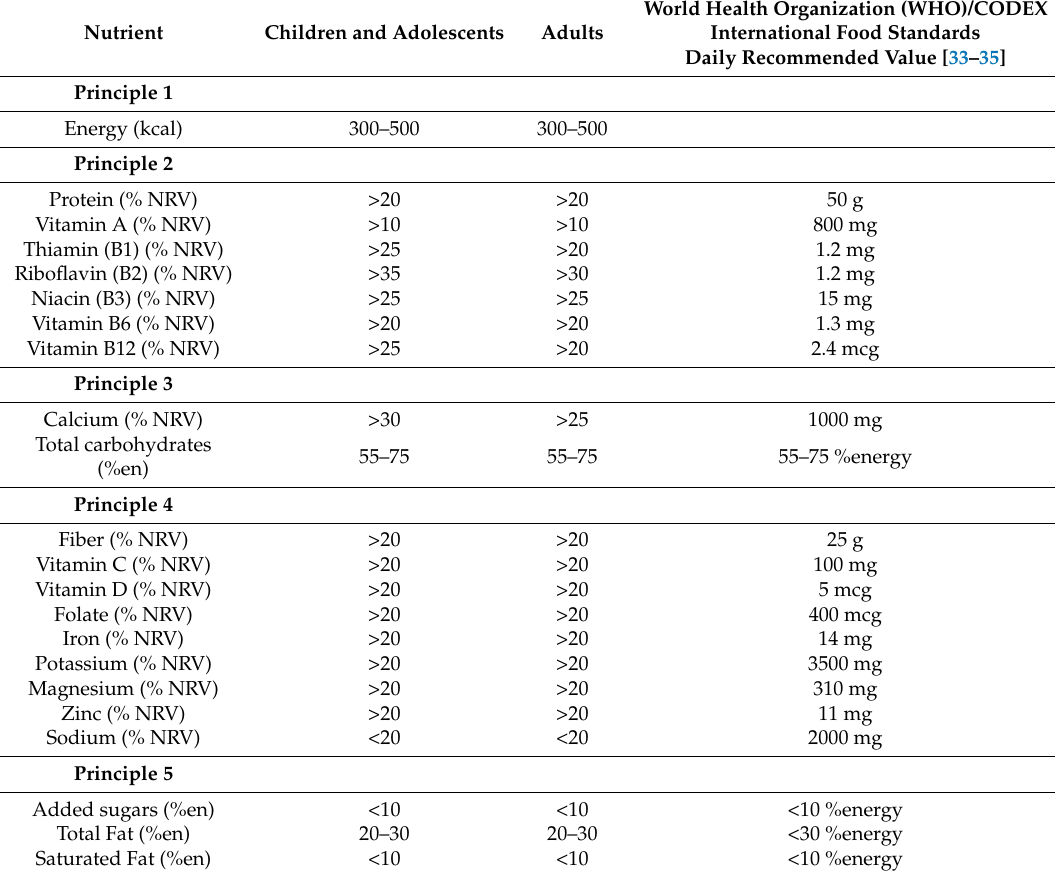
Table 4. Proposed nutrient recommendations for the breakfast eating